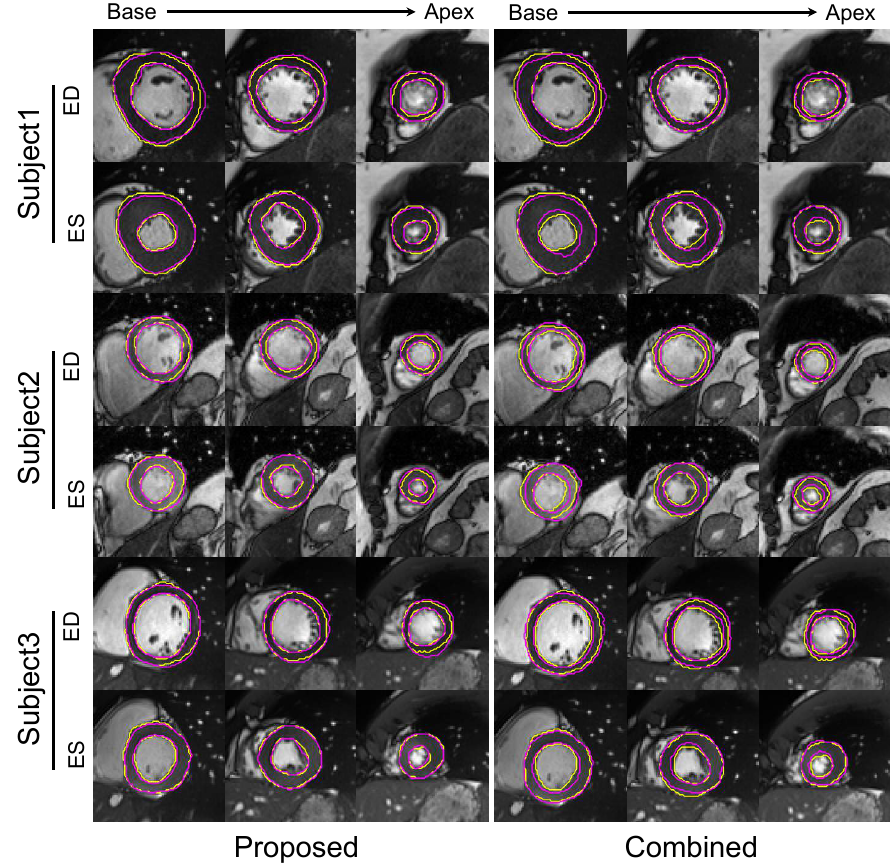
Figure 2. Representative segmentation of different regions of the heart at end-systole and end-diastole for three unseen ACDC test subjects (Subject1, Subject2, and Subject3) using the proposed (left) and the combined (right) methods. Algorithm and manual segmentation are shown in purple and yellow, respectively. ED: end-diastole; ES: